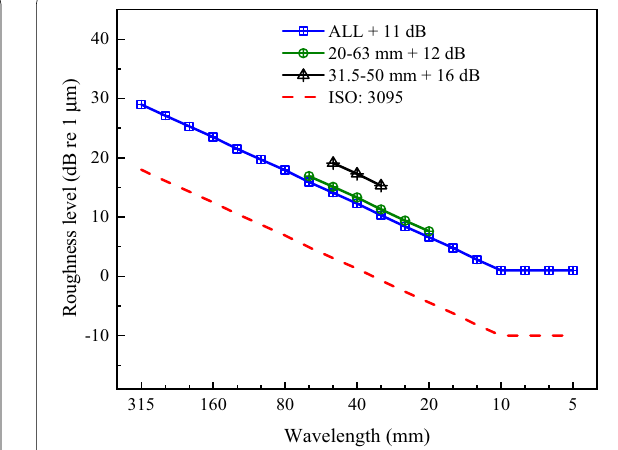
Figure 18 Rail roughness limits for ballast track at 60 km/h